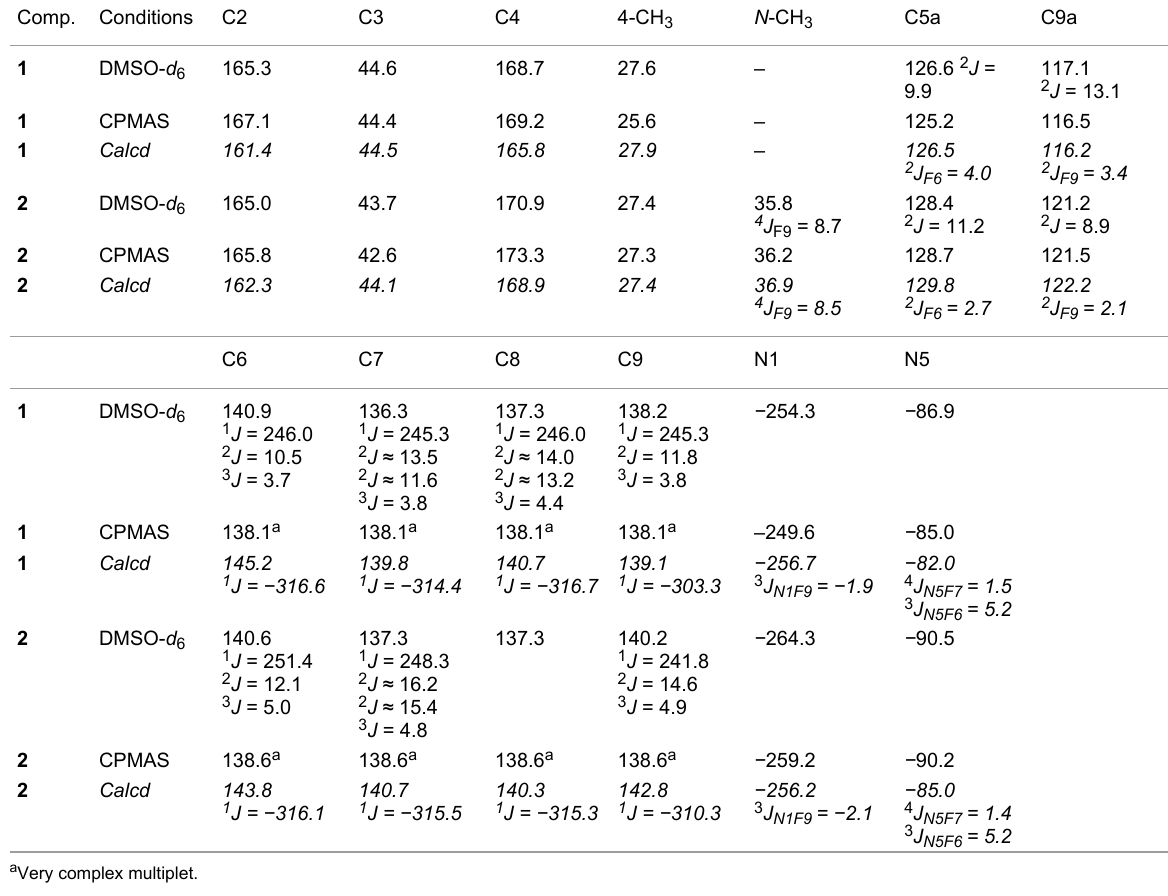
Table 3: 13 C and 15 N NMR chemical shifts ( δ , ppm) and some coupling constants (Hz) of compounds 1 and 2 in solution and in the solid state together with the calculated values (ppm and Hz). Comp. Conditions